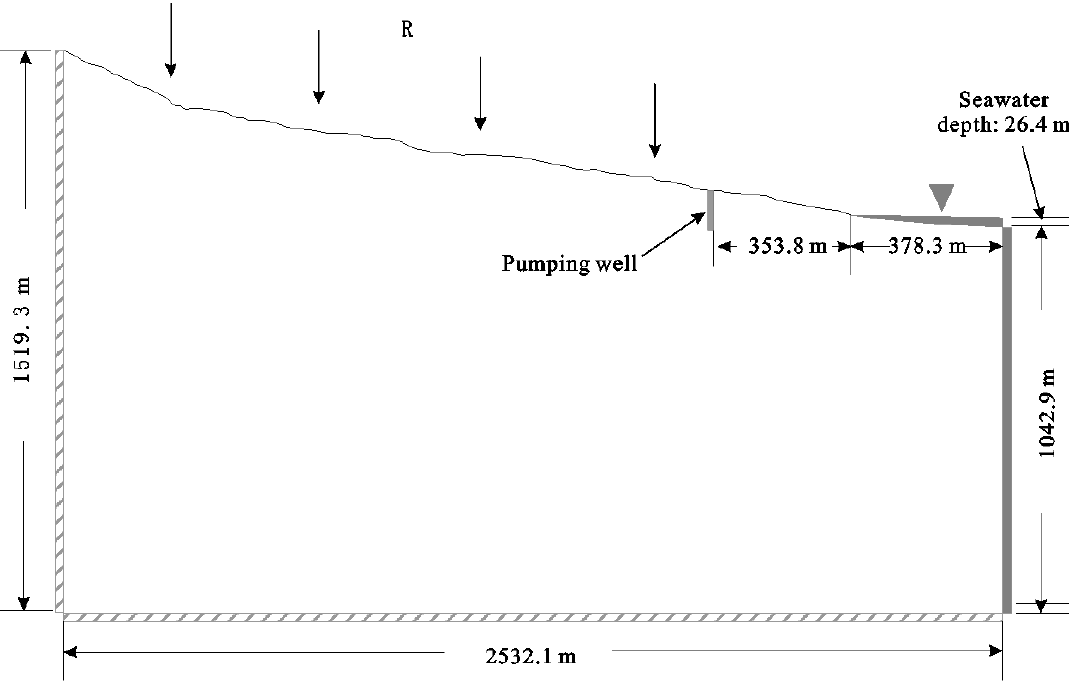
Figure 1. Map of the conceptual model that was used in the hypothetical 2D study.